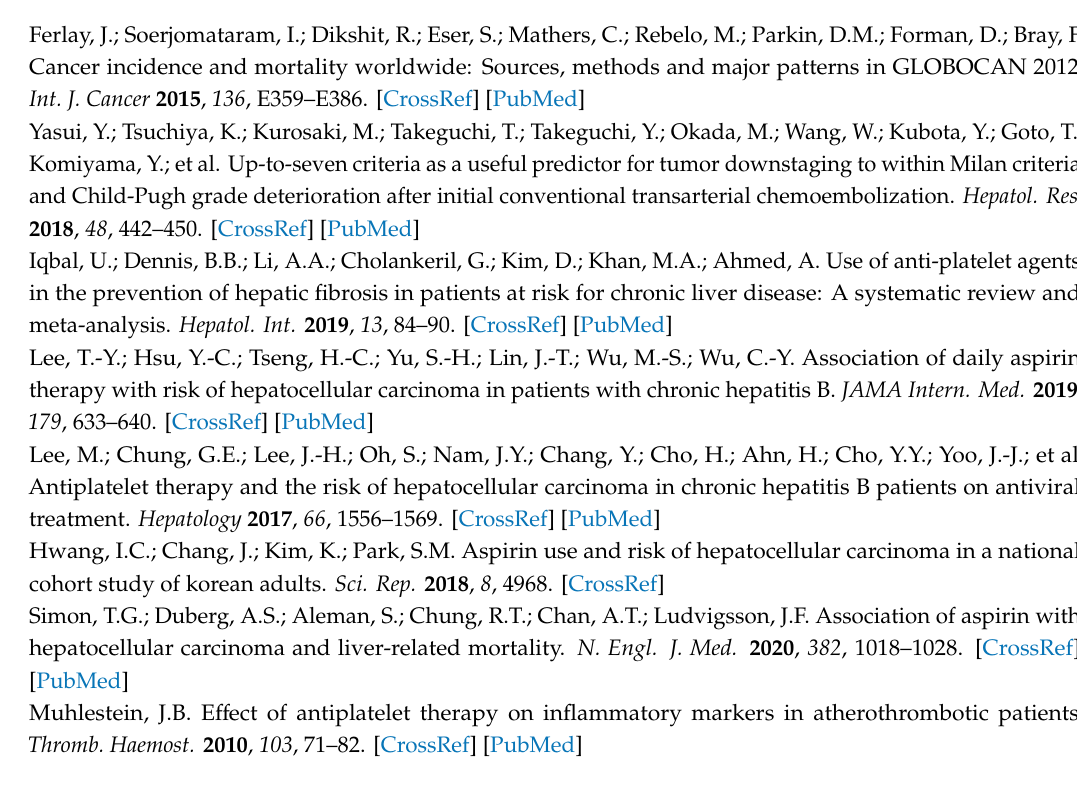
Figure S1: Patients with HCC who entered in this study, Figure S2: Antiplatelet therapy was associated with better prognosis after propensity score matching. Five-year survival in patients with antiplatelet therapy was significantly better than that without antiplatelet therapy (59.7% versus 32.9%, p = 0.01), Table S1: Baseline characteristics in HCC patients undertaking or not undertaking antiplatelet therapy after propensity score